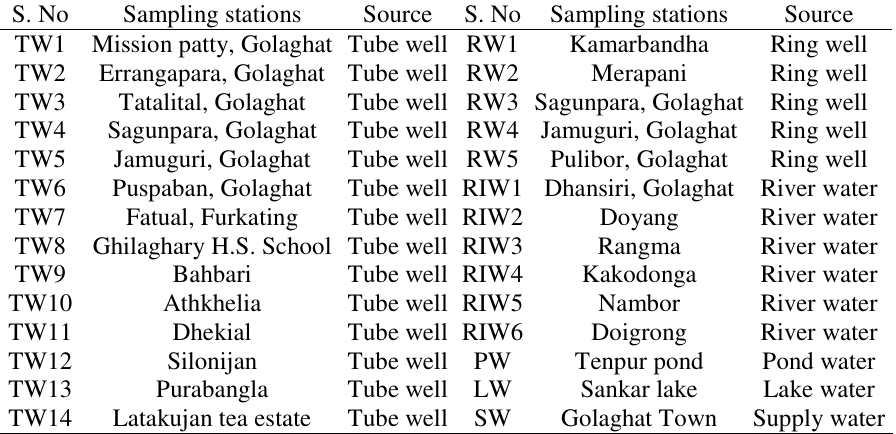
Table 1. Water sampling locations and sources